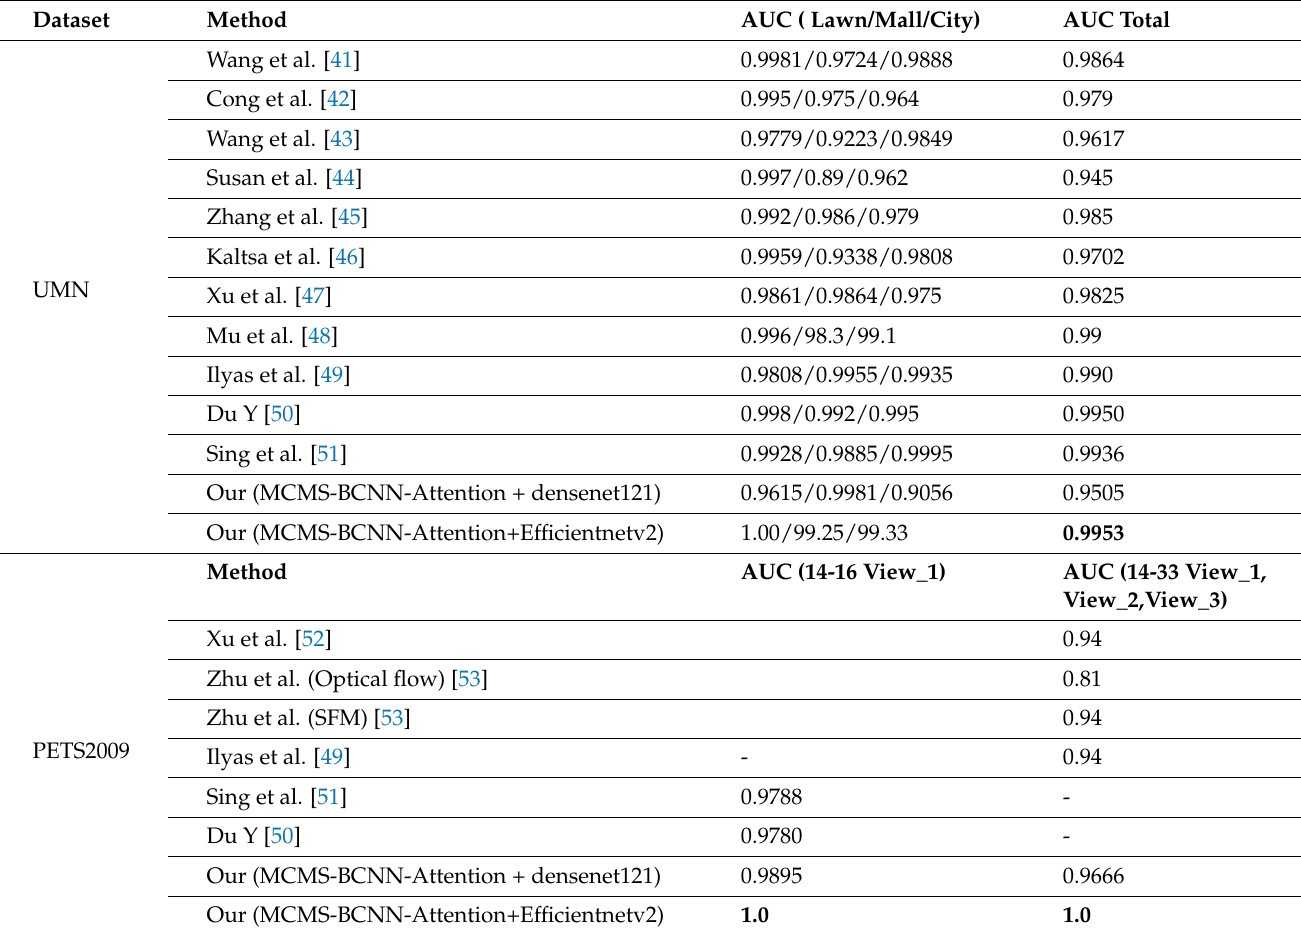
Table 7. Performance comparison of the proposed approach with existing techniques on UMN and PETS2009